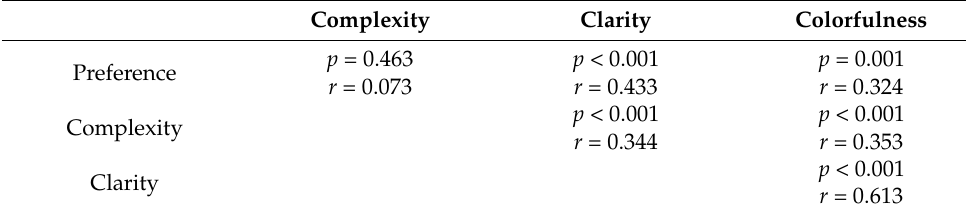
Table 4. Mann-Whitney U test p -values and effect size r between subjective evaluations.